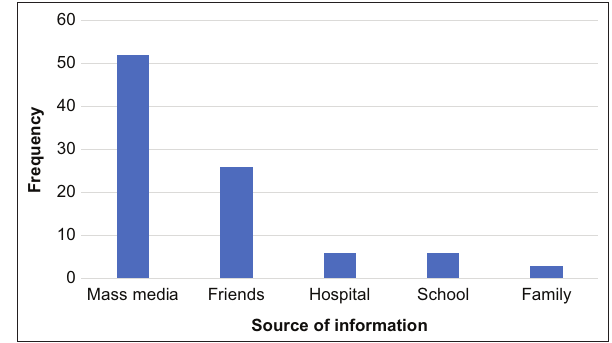
Figure-1: Sources of information on Lassa fever among